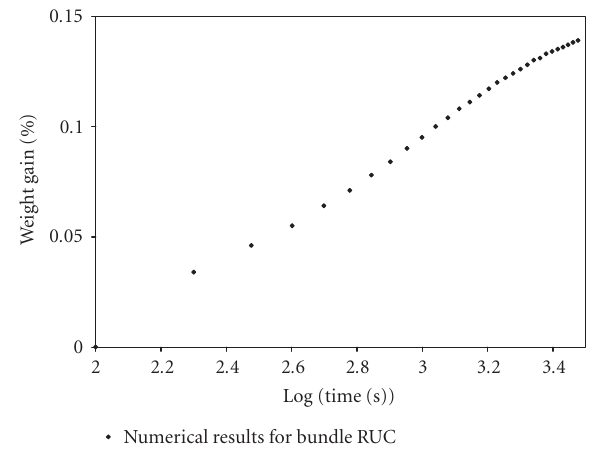
Figure 12: Weight gain as a function of the time for bundle RUC by postprocessing of numerical results from the FEM analysis.